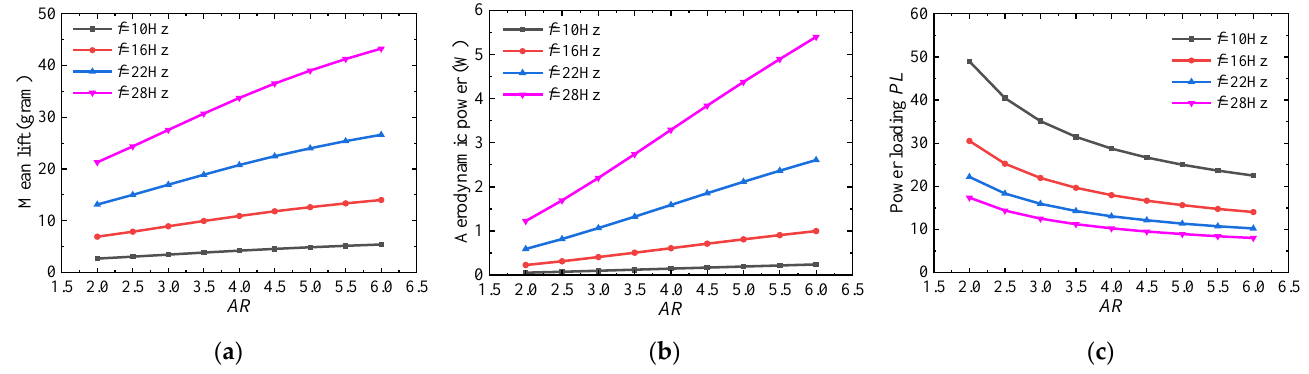
Figure 4. Aerodynamic performance of wings with different AR . ( a ) Mean lift of different AR . ( b ) Aerodynamic power of different AR . ( c ) Power loading of different AR .